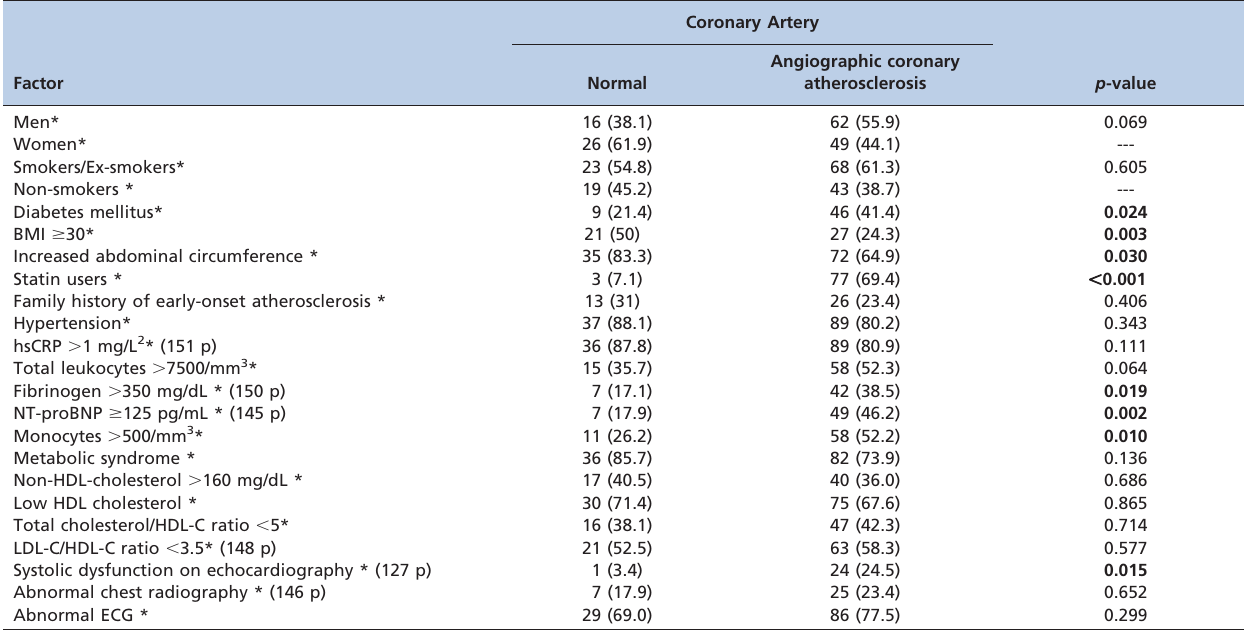
Table 3 - Comparison of Groups A and B with respect to categorical variables.